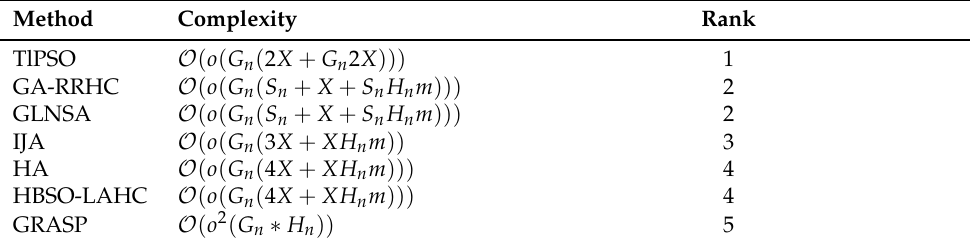
Table 3. Computational complexity of the methods used in the experiments.